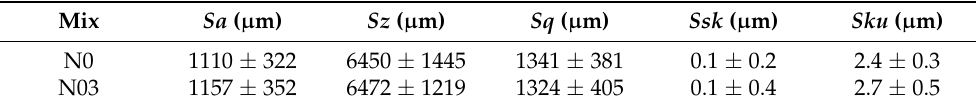
Figure 17. Representative 3D topographic images (20 mm × 20 mm ca) of the mortars fractured surfaces with 0% FC (N0) and 0.3% FC (N03). Table 7. Average surface roughness values obtained from 3D scans of fractured surfaces after three- point-bending tests.